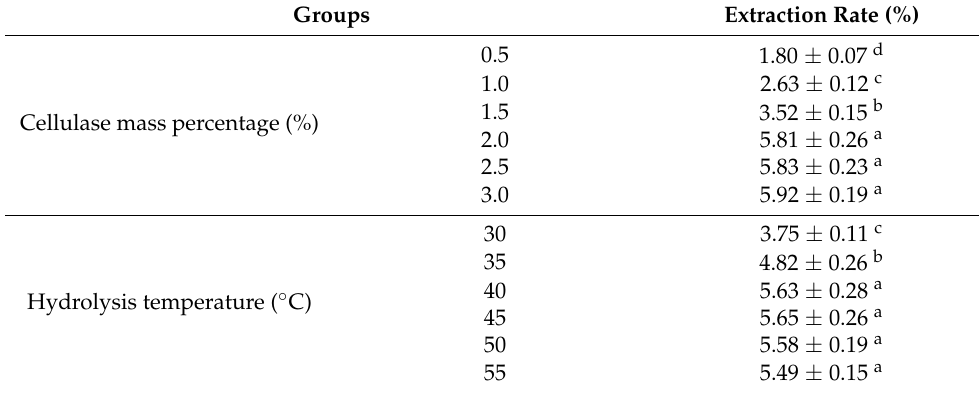
Table 1. Effect of cellulase mass percentage and hydrolysis temperature on flavonoids extraction rate.